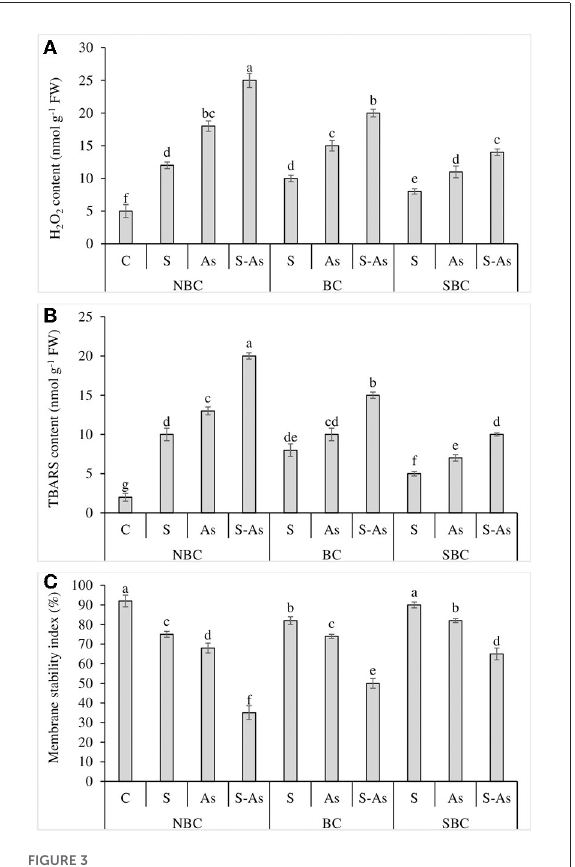
FIGURE3 Effect of salinity, arsenic, and their combination on H 2 O 2 contents (A) , TBARS contents (B) , and membrane stability index (C) of quinoa supplemented with no biochar (NBC), biochar (BC), and silicon-nanoparticles doped biochar (SBC). The values (average ± SE of four replicates) followed by different letters represent the significant difference at a significance level of 5%.